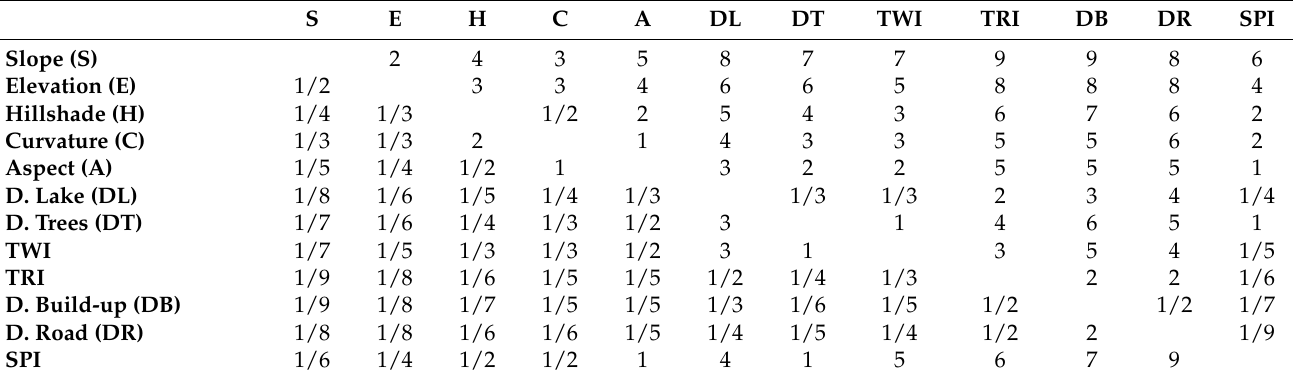
Table 2. The pairwise comparison matrix of the landslide